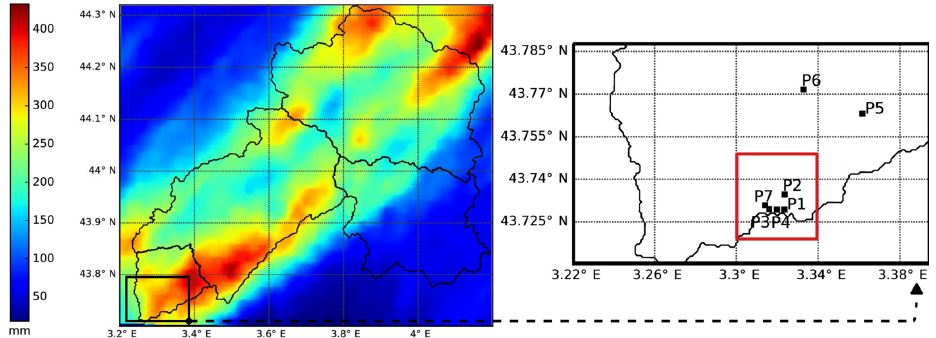
Figure 12. Cumulated rainfall during the 12 September 2015 event and the location of points P1–P7 (black squares) within the Lergue catchment in zone A.